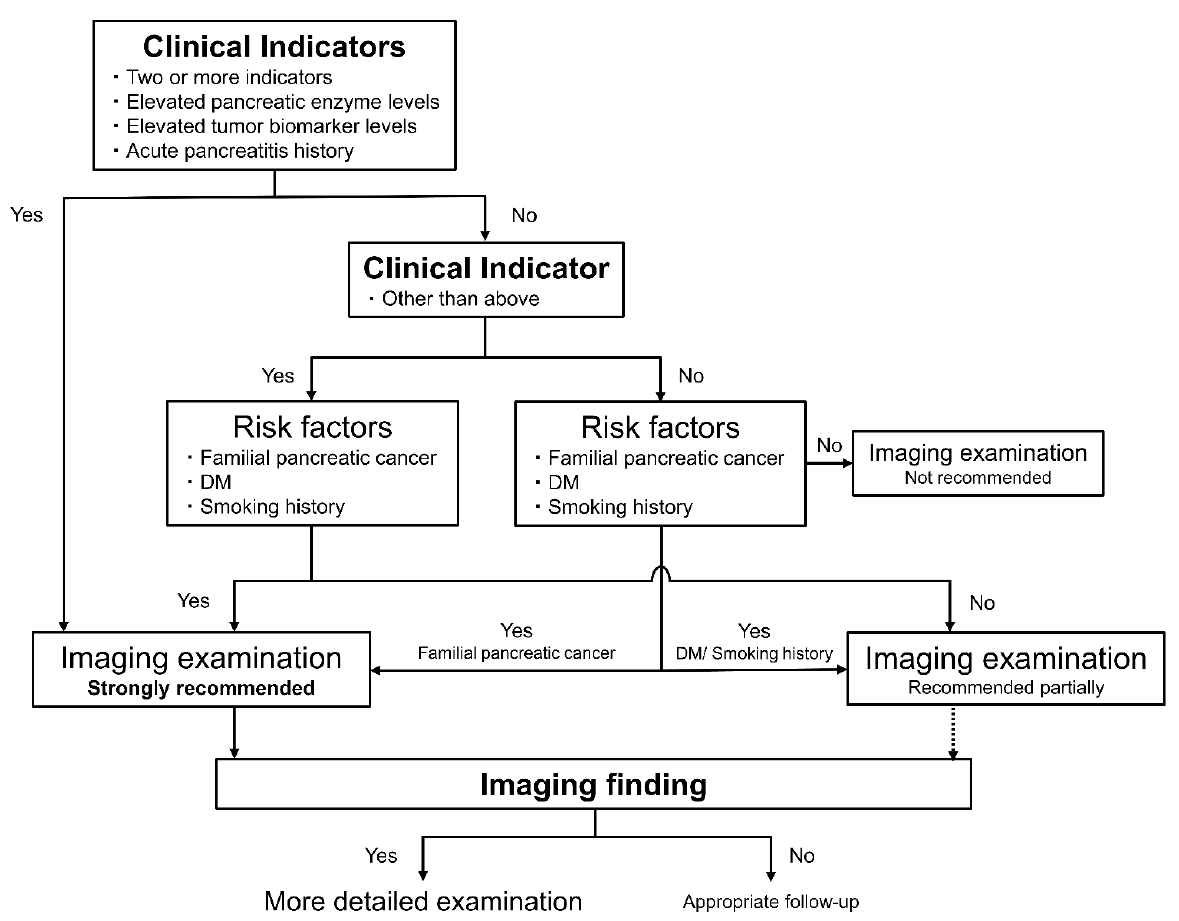
Figure 2. Newly constructed step-by-step diagnostic strategy for early stage PDAC evaluating clin- ical indicators, risk factors, and indirect imaging findings in outpatients. Considering the significant factors for early stage PDAC detection, we found that imaging examination can be strongly recom- mended in individuals with two or more clinical indicators, one significant indicator, or one clinical indicator with one significant risk factor. For patients with no clinical indicators but with one sig- nificant risk factor of familial pancreatic cancer, imaging examination may also be strongly recom- mended. DM, diabetes mellitus; IPMN, intraductal papillary mucinous neoplasm; MPD, main pan- creatic duct; PDAC, pancreatic ductal